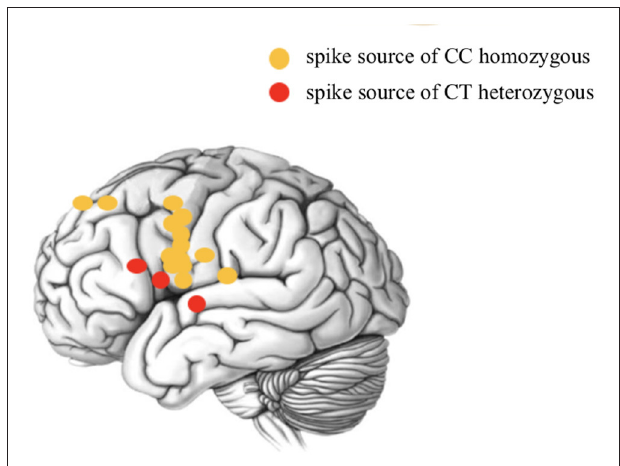
FIGURE 2 | Schematic diagram of the CTS source distribution of ELP4 rs662702 in patients with different genotypes.